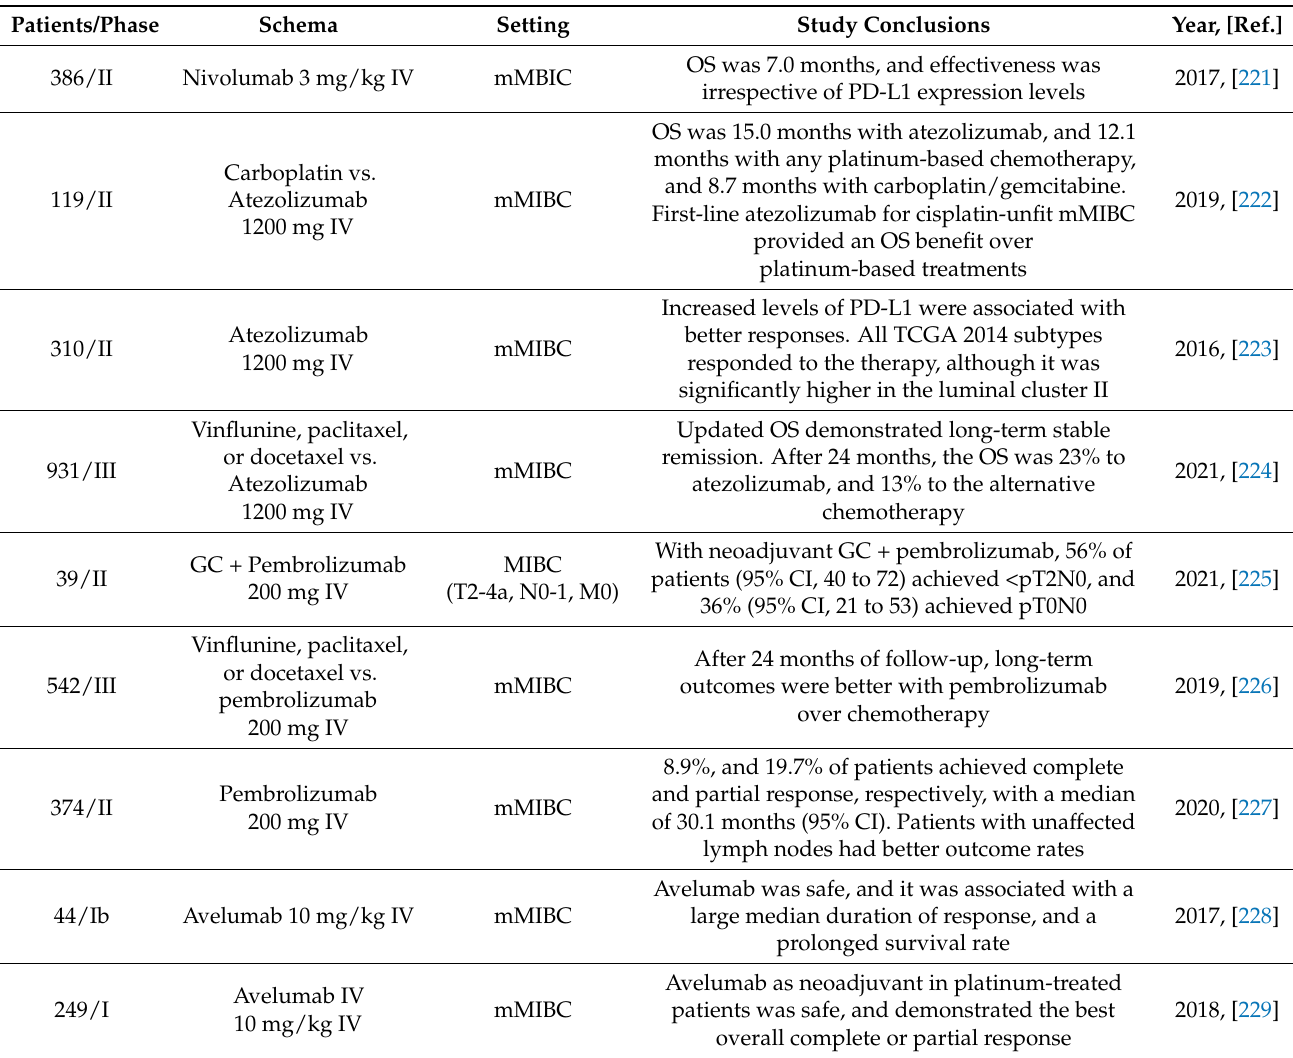
Table 3. Clinical trials using approved ICI immunotherapy in the treatment of bladder cancer.